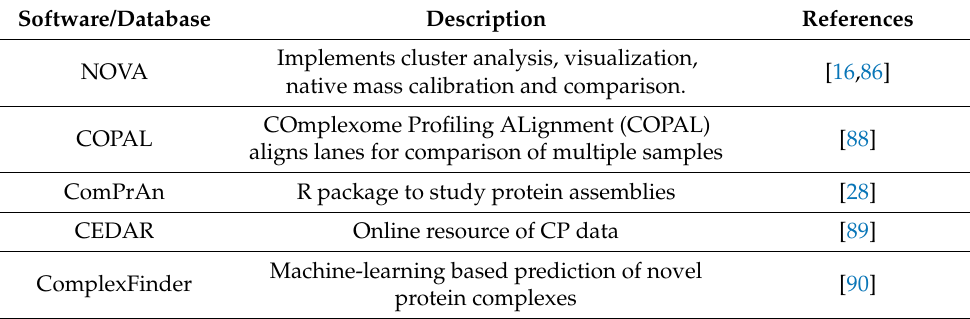
Table 2. Tools to analyze complexome profiling